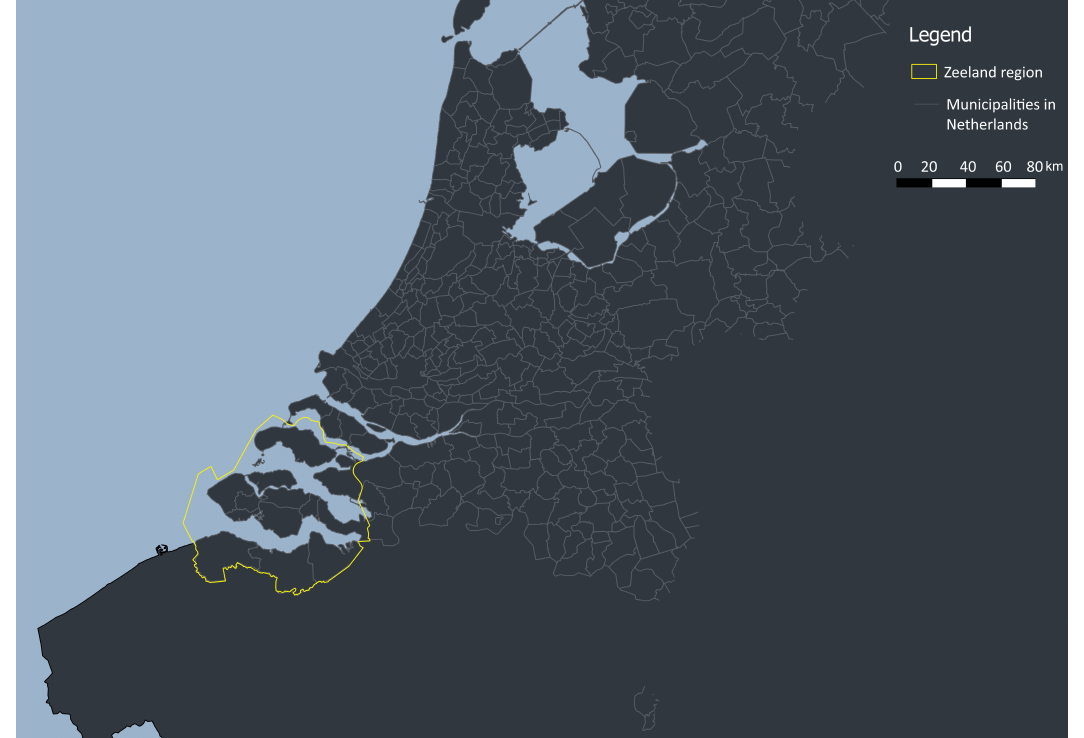
Figure 1. Province of Zeeland, the